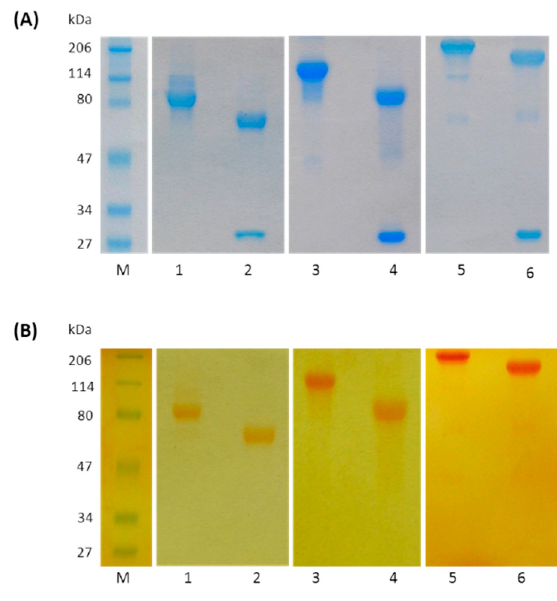
Figure 3. SDS-PAGE analysis (10% separating gel) of PEGylated Fab fragments. PEGylated Fab fragments were detected with Bio-Safe Coomassie stain ( A ) and with iodine stain ( B ) protein standards (lane M); purified Trast Fab-(N-Term)-PEG 20 kDa under non reducing (lane 1) and reducing conditions (lane 2); purified Trast Fab’-Cys-PEG (2 × 10 kDa) under non reducing (lane 3) and reducing conditions (lane 4); and purified Trast Fab’-Cys-PEG (2 ˆ 20 kDa) under non reducing (lane 5) and reducing conditions (lane 6). Reduction was achieved by treating samples with 2-mercaptoethanol before